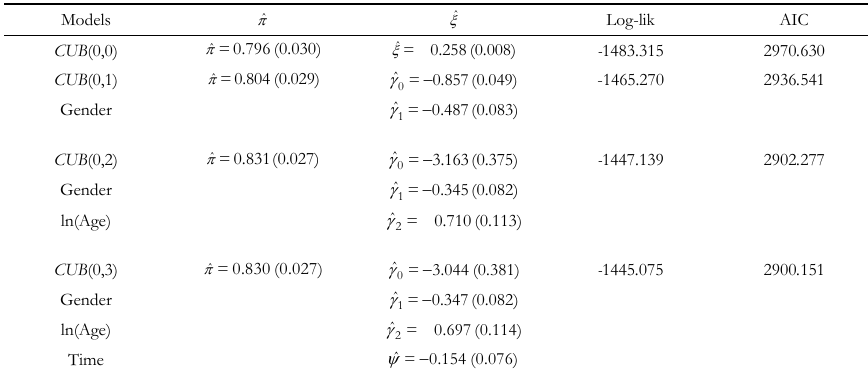
Estimated CUB models for Environmental